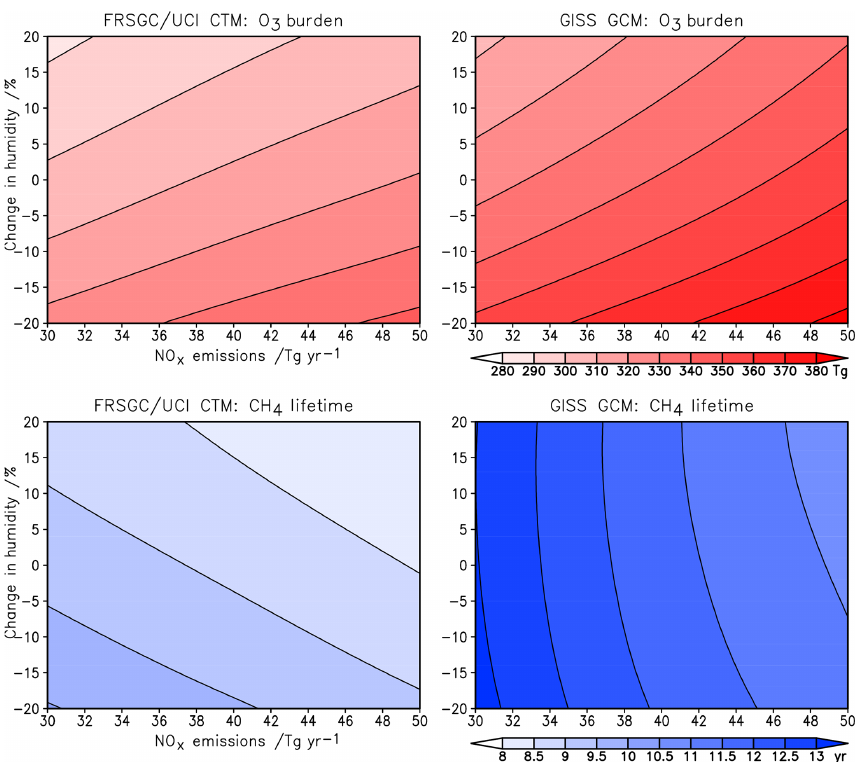
Figure 5. Sensitivity of tropospheric O 3 burden and CH 4 chemical lifetime to changes in surface NO x emissions and humidity in the FRSGC/UCI CTM and GISS